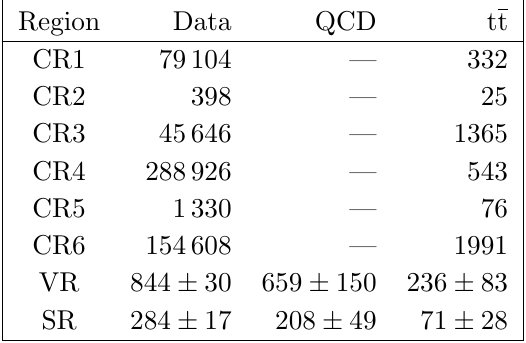
Table 4 . Event yield table after various selections. The de(cid:12)nition of each region is given in table 1. The uncertainties shown here for the validation region and the signal region are pre (cid:12)t; the posteriori uncertainties for tt and QCD are constrained down by 40 and 14%,